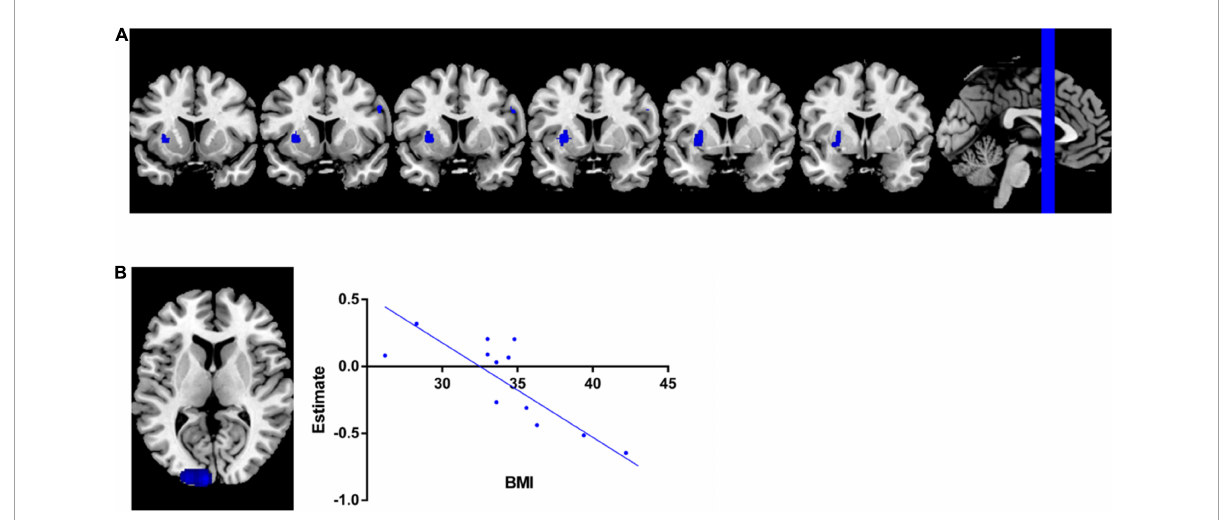
FIGURE2 Meta-analysis results. (A) Regions showed lower GMV in overweight and obesity subjects than leans group. (B) Meta-regression analysis indicated that GMV in left middle occipital gyrus was significantly negatively associated with BMI in overweight and obesity individuals.